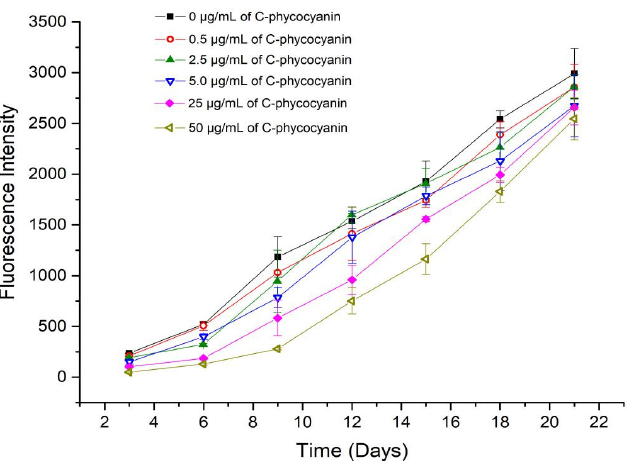
Figure 2. Inhibitory effect of C-phycocyanin on amyloid formation using fluorometric assay for a 21-day duration.